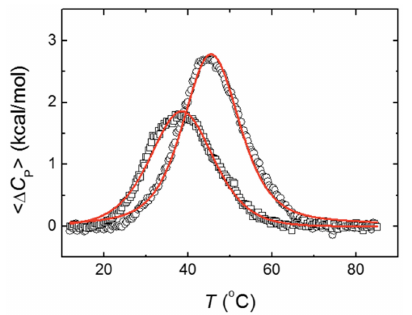
Figure 1. Differential scanning calorimetry thermograms (excess molar heat capacity of the protein as a function of temperature) for MBD (squares) and NTD-MBD-ID (circles). Experiments were done with a concentration of 40 µM, in Tris 50 mM, pH 7. Non-linear fittings are shown (red), according to a single transition model (for MBD) and a two independent transitions model (for NTD-MBD- ID). The model-free van‘t Hoff analysis indicated that MBD unfolds as a single transition, whereas NTD-MBD-ID unfolds through two independent transitions, because the en- thalpies ratio is close to 1 for MBD, but rather lower than 1 for NTD-MBD-ID (Table 1). The thermal unfolding monitored by fluorescence (using the single tryptophan W104 as an intrinsic probe) was previously analyzed according to a single transition (two-state model) and provided unfolding parameters in reasonable agreement with those reported now: transition temperature of 38.4 and 46.2 °C for MBD and NTD-MBD-ID, respectively, and unfolding enthalpy of 29 and 37 kcal/mol for MBD and NTD-MBD-ID, respectively. Thus, it seems that the presence of the two disordered flanking domains increased the stability of MBD and the unfolding process of the longer construct occurred with unfold- ing intermediates. Table 1. Parameters associated with the van ‘t Hoff test (or calorimetric two-state test). Protein Construction T m ( ° C ) Δ H cal ( kcal/mol ) C Pmax ( kcal/K · mol ) Δ H vH ( kcal/mol ) Ratio MBD